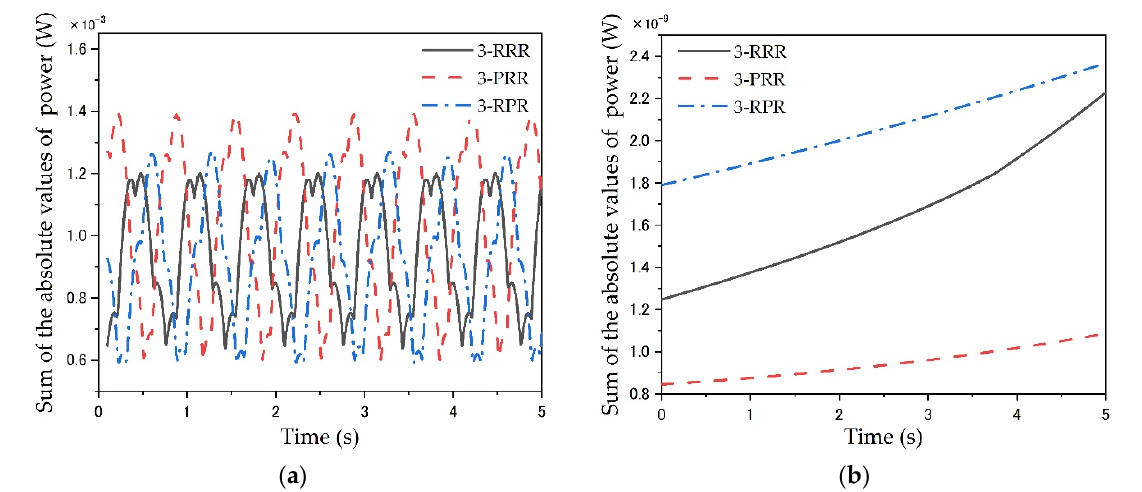
Figure 15. The sum of the absolute values of the power requirements of three PPMs: ( a ) for the circular trajectory; ( b ) for the linear trajectory.